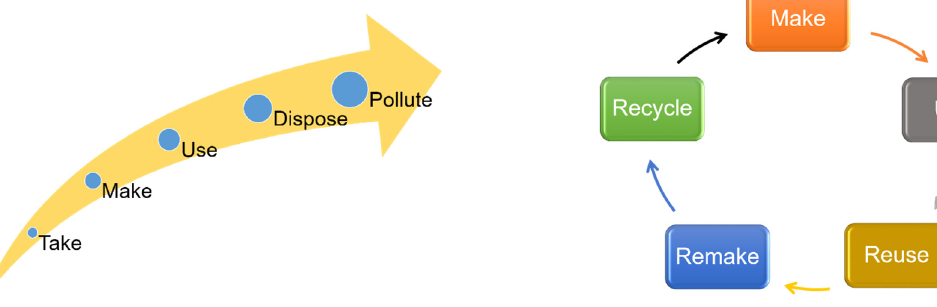
Figure 2. Schematic depiction of linear economic models (left) and circular sustainability models (right)